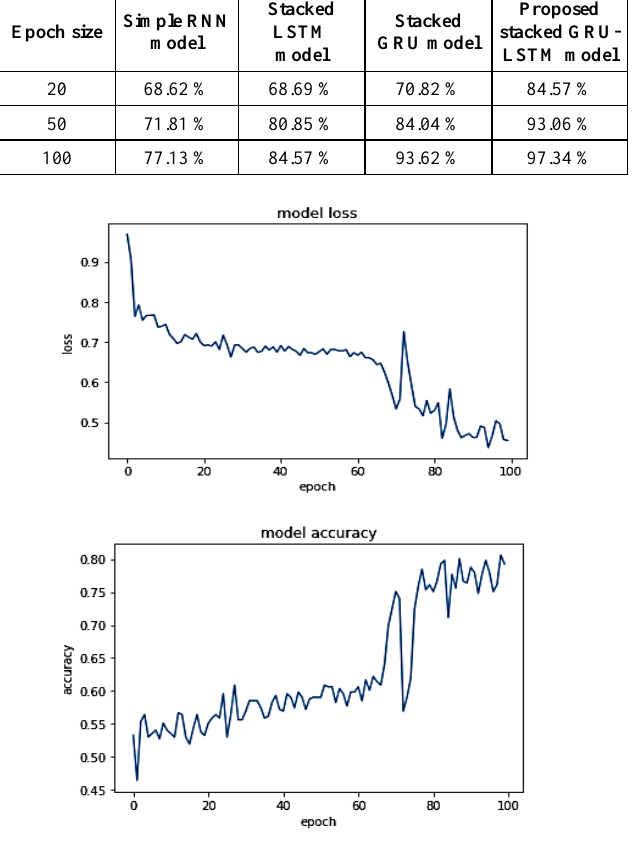
Fig. 3. Loss and accuracy plot of stacked simple-RNN model obtained over